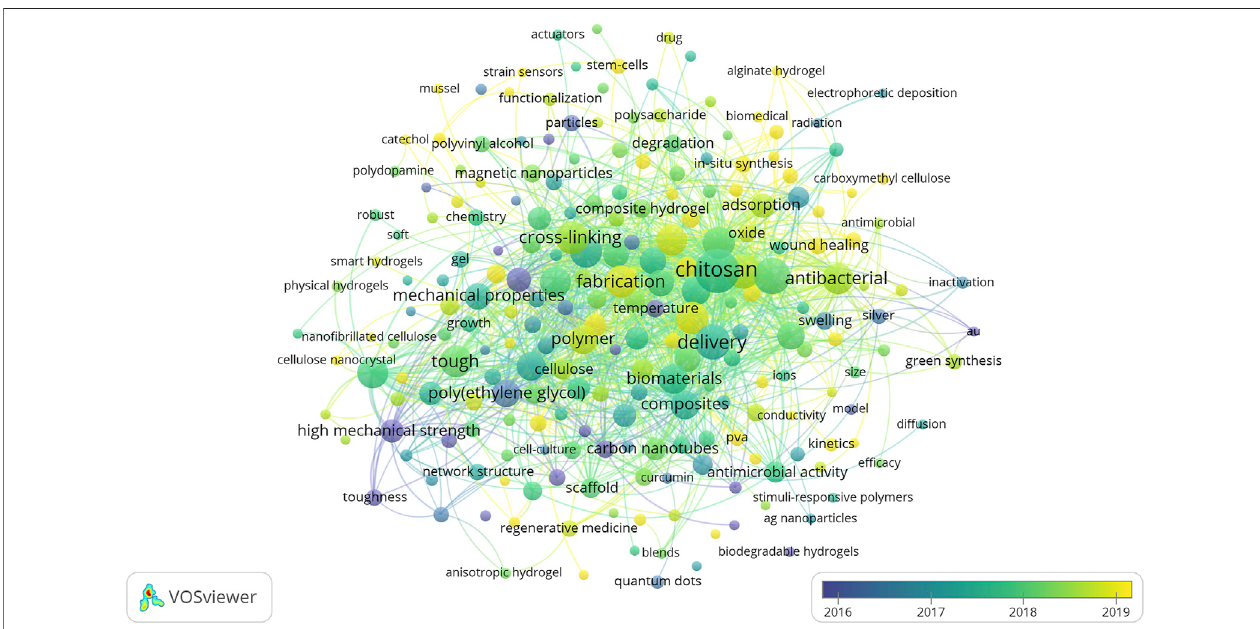
FIGURE 8 | Visualization based on keyword co-occurrence